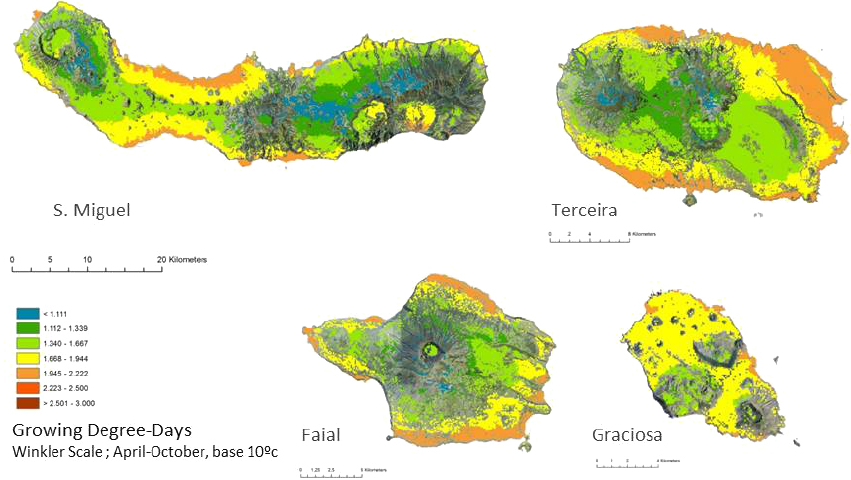
Figure 1. Winkler scale distribution for S. Miguel, Terceira, Faial and Graciosa islands of the